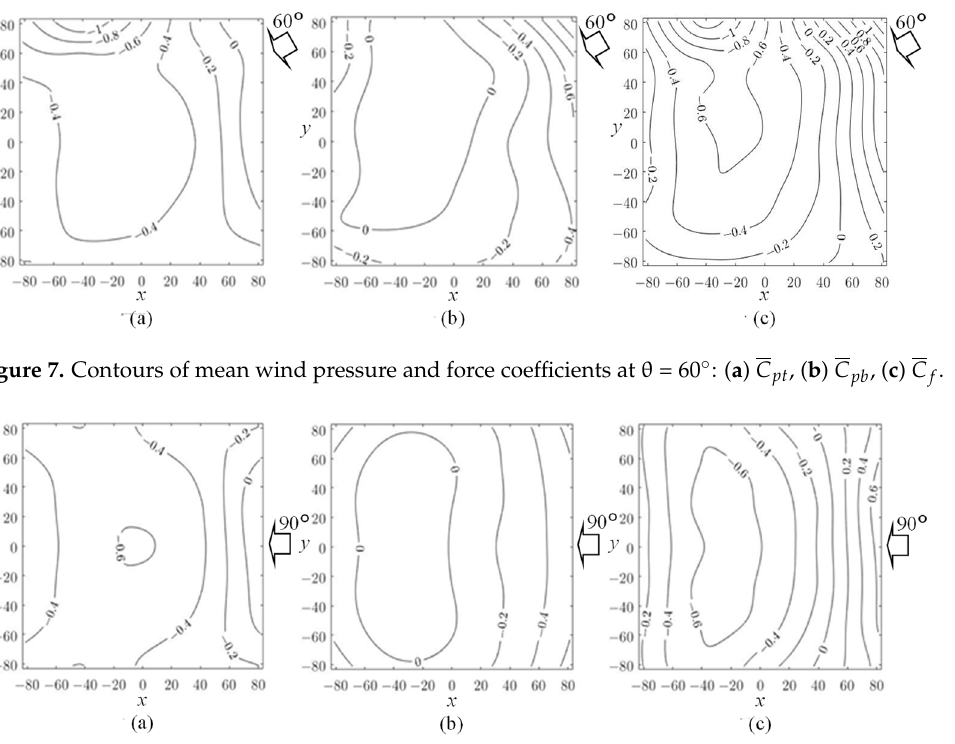
Figure 8. Contours of mean wind pressure and force coefficients at θ = 90°: ( a ) 𝐶̅ (cid:3043)(cid:3047) , ( b ) 𝐶̅ (cid:3043)(cid:3029) , ( c ) 𝐶̅ (cid:3033) .